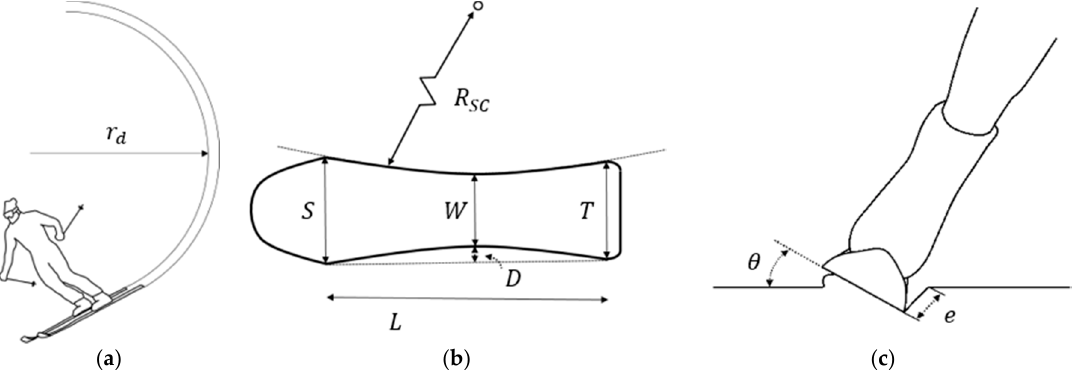
Figure 2. ( a ) Turn radius r d ; ( b ) Parameters characterizing of ski geometry; ( c ) Edging angle θ and penetration depth e